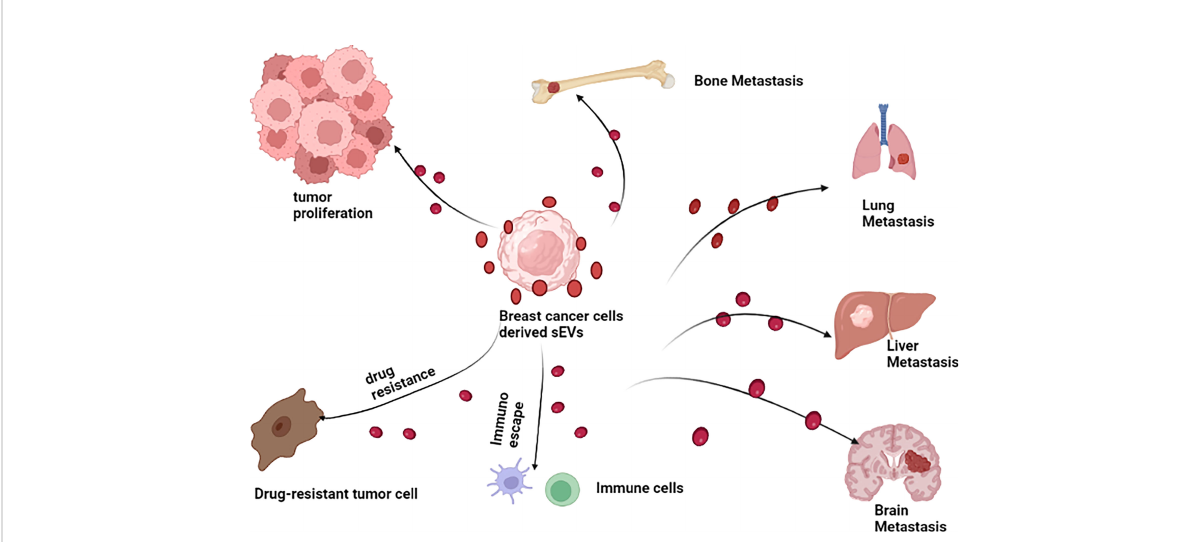
FIGURE 3 Breast cancer cell derived sEVs have potential role in promoting breast cancer growth, invasion and metastasis, modulating immune escape and drug